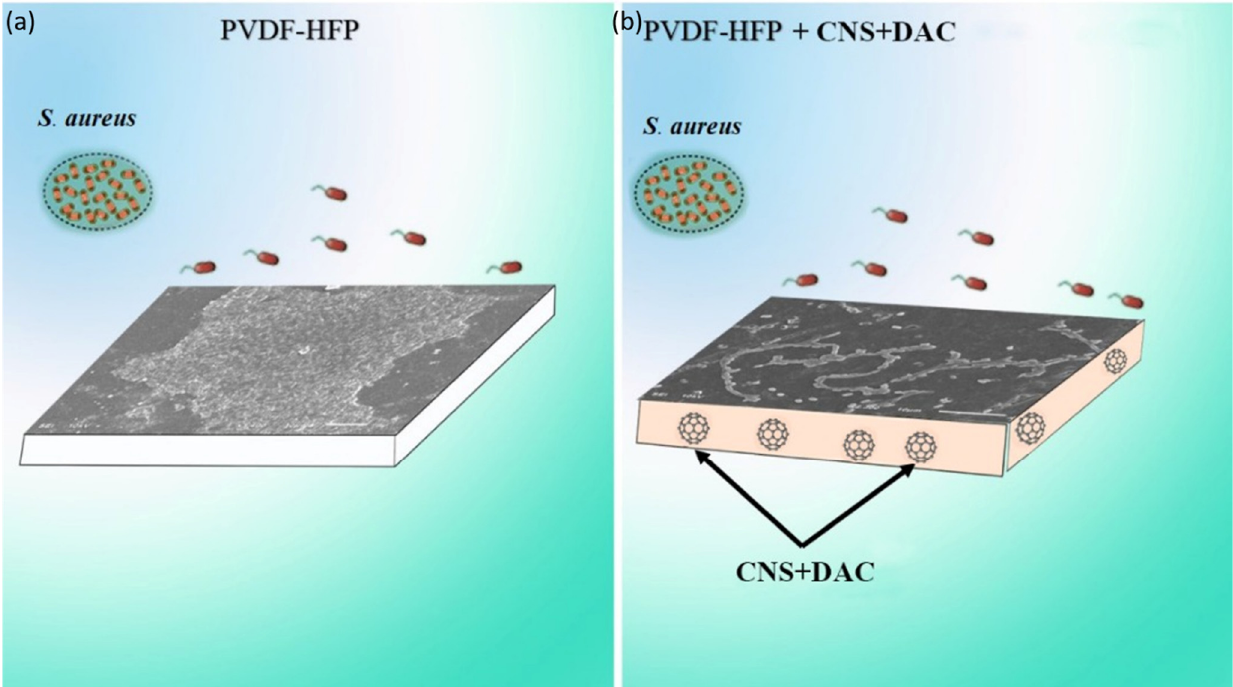
Figure 11. Bacterial adhesion on ( a ) the pristine membrane and ( b ) the CNS-DAC membrane.